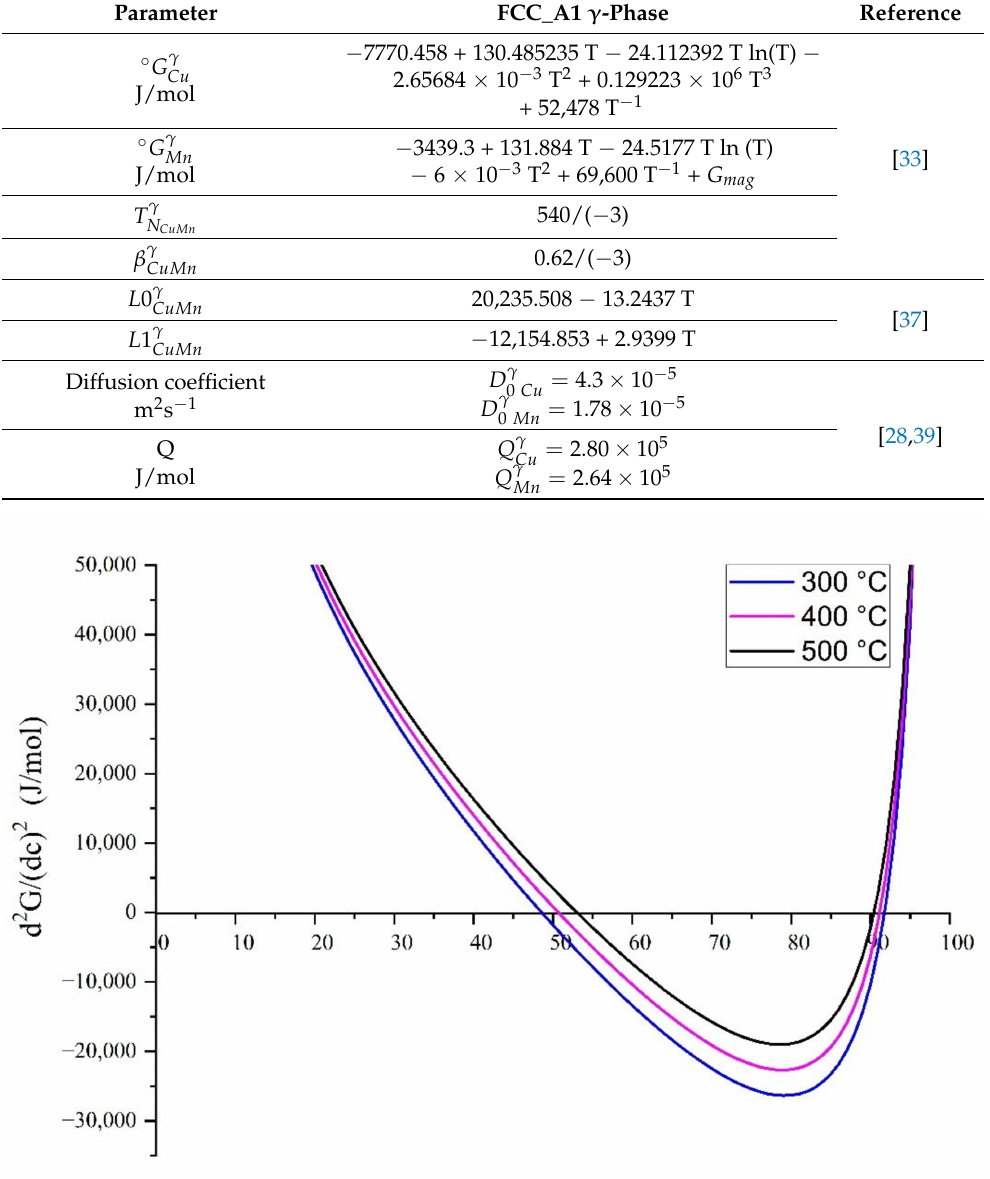
Table 1. Thermodynamic parameters for the calculation of chemical equilibrium.